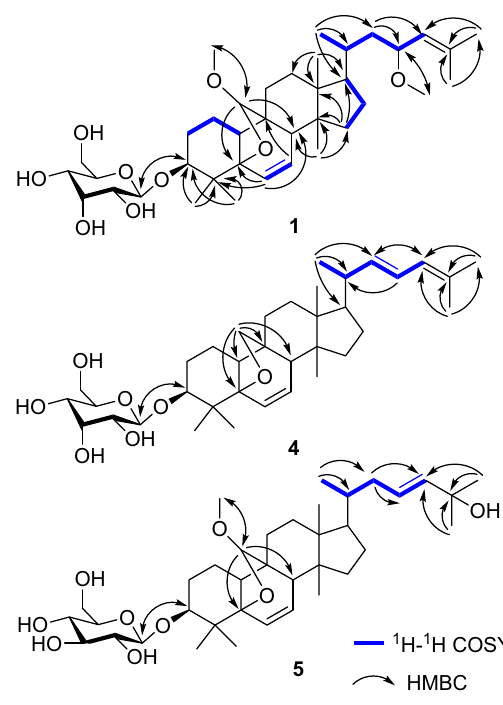
Fig. 2 Key 1 H- 1 H COSY and HMBC correlations of 1 , 4 , and